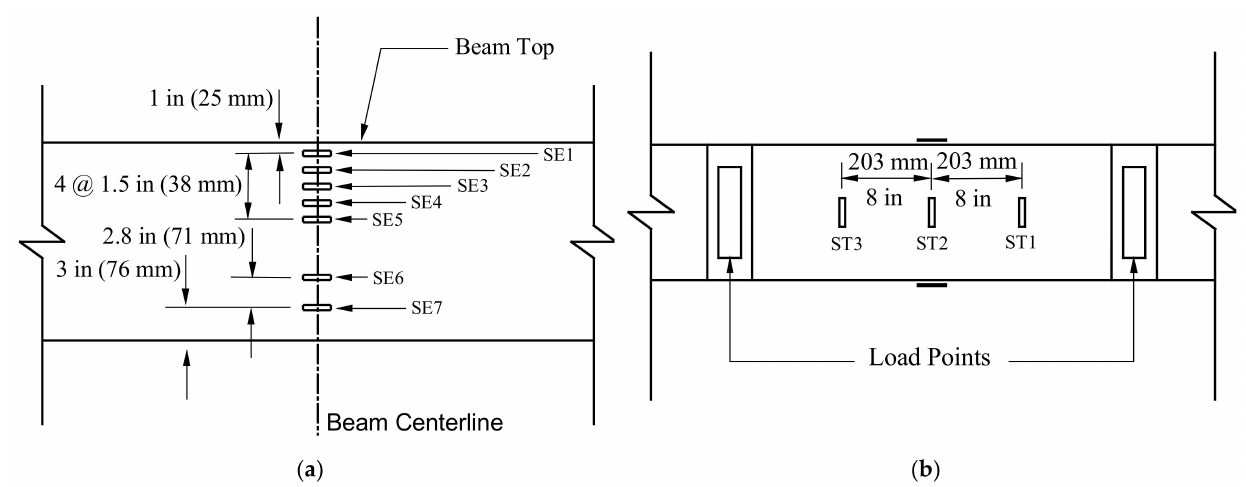
Figure 13. Strain gage arrangement at beam mid-span: ( a ) east side of the beam, and ( b ) top of the